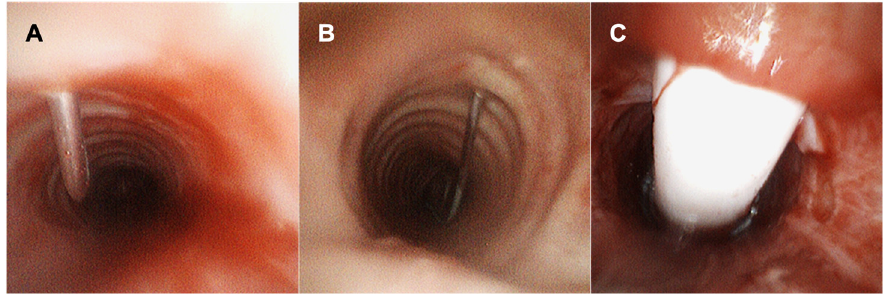
Figure 2. Using SUFB for Percutaneous Tracheostomy Tube Placement. This figure illustrates tracheostomy placement using the SUFB (EXALT Model B Single-Use Bronchoscope from Boston Scientific). Needle insertion ( A ), passing of the guidewire ( B ), and placement of the tracheostomy tube ( C ) are visualized.